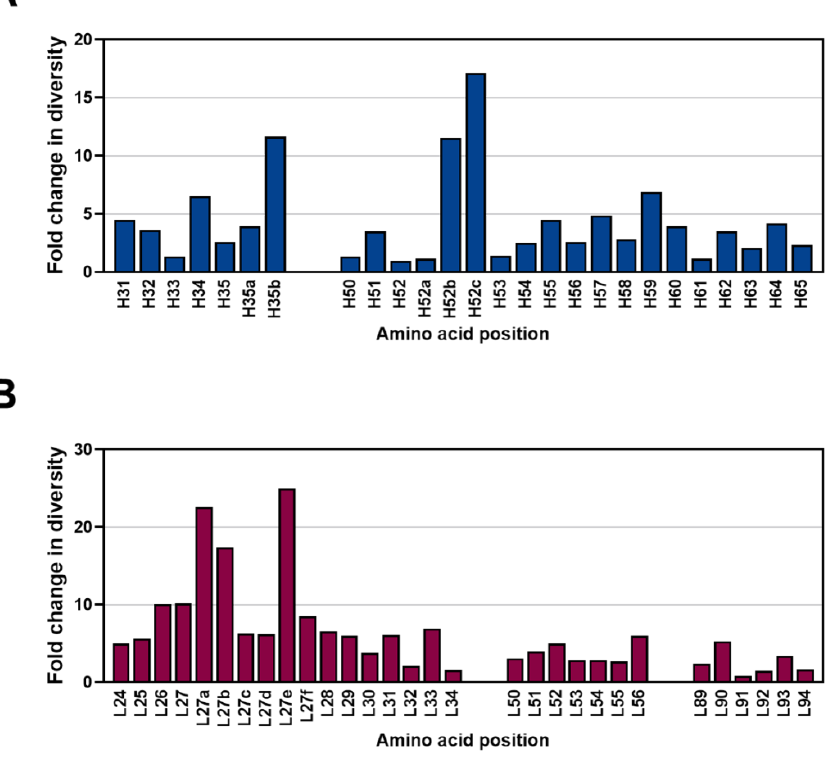
Figure 8. Analysis of the diversity in heavy chain complementarity-determining regions (HCDRs) and light chain complementarity-determining regions (LCDRs) in the constructed library. The HCDR1 and HCDR2 of heavy chain variable domain ( A ) or LCDR1, LCDR2 and LCDR3 of light chain variable domain ( B ) are shown in blue and red colors, respectively. Individual diversity equals the total number of different residues at each position, divided by the relative frequency of the most common residue at that position. The x axis shows the amino acid position based on Kabat numbering.